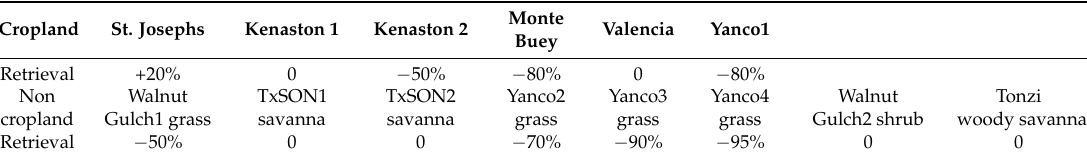
Table 5. VWC retrieval using SMAP data, presented in terms of the modification factor, f in %. The values are consistent with the plots shown in Figure